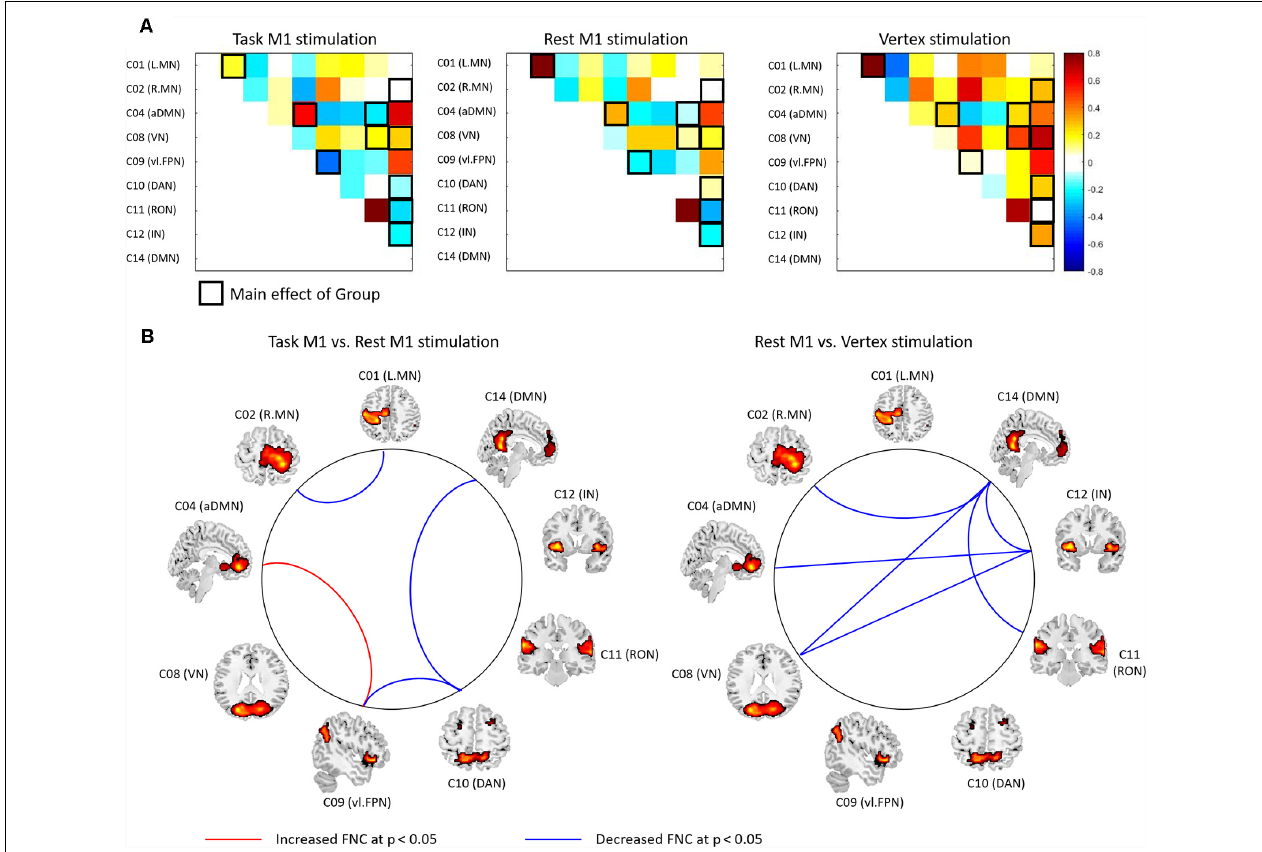
FIGURE 6 | The results of functional network connectivity (FNC) analysis between groups. (A) The FNC matrix. Pairwise correlation coefficients between RSN time courses were Fisher z-transformed and averaged across subjects within the task M1 (left M1 TMS session), rest M1 and vertex stimulation groups. The black boxes indicate the FNC that showed a significant group effect ( p < 0.05). Warm colors indicate the positive coupling and cool colors indicates the negative coupling (decoupling) between the networks. (B) The FNC comparisons between two groups (left: Task M1 vs. Rest M1 stimulation; right: rest M1 vs. Vertex stimulation). The red-line indicates the increased FNC and blue line shows the decreased FNC between the groups ( p <